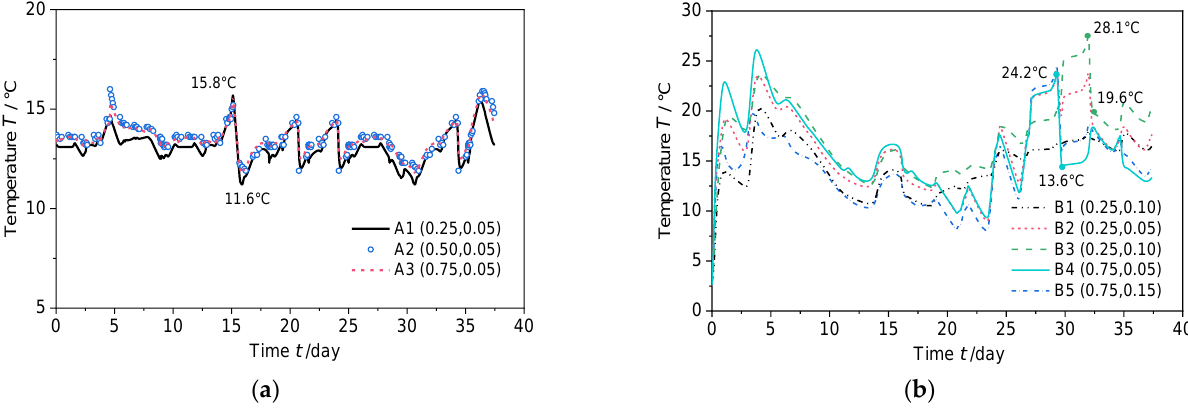
Figure 7. Temperature curves with time. ( a ) Ambient temperature group; ( b ) solar heating group.